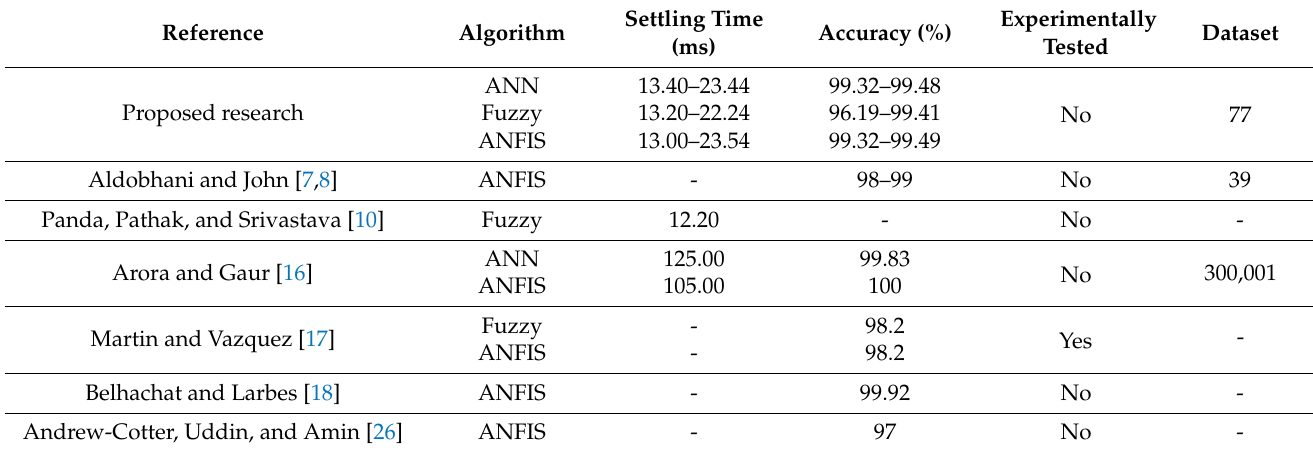
Table 11. Comparison with other published studies.